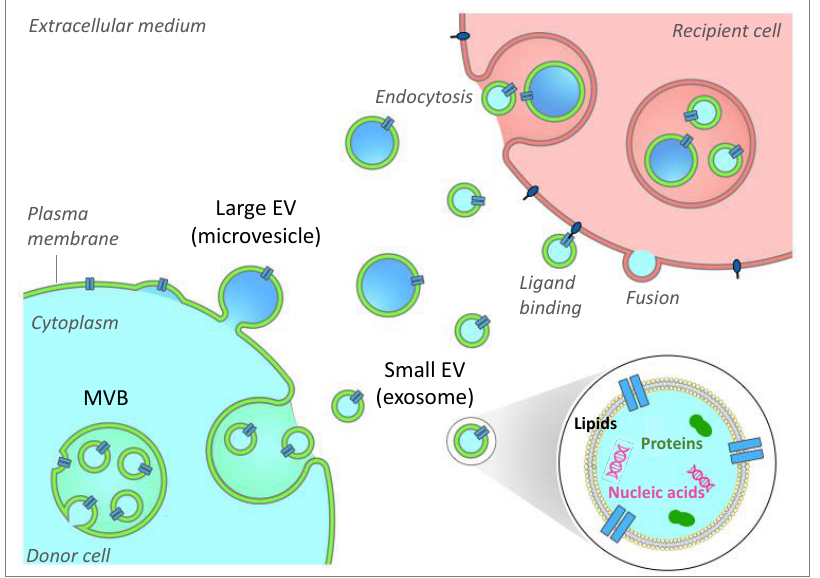
Figure 1. Extracellular vesicle biogenesis, secretion and interaction with recipient cells. Two subclasses of extracellular vesicles (EV) are released from mammalian cells and are mainly distinguished based on their sizes. Large EVs (lEV) can bud from the plasma membrane. They are also referred to as microvesicles. Small EVs are derived from the formation of intraluminal vesicles (ILVs) within the lumen of the multivesicular body (MVB). MVB can fuse with the plasma membrane to release ILVs, which are thus called exosomes. EVs participate in intercellular communication through EV-based exchanges of proteins, lipids and genetic material between cells. The fate of EVs in recipient cells includes membrane fusion, ligand binding or endocytosis mechanisms.